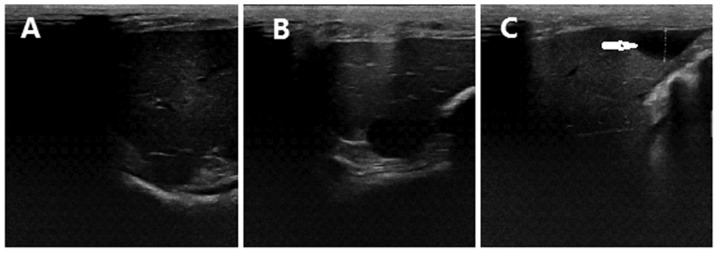
Two-dimensional images of rabbit livers. (A) Normal rabbit liver. (B) Simple fatty liver. (C) Alcoholic fatty liver (the scale bar indicates ascites).